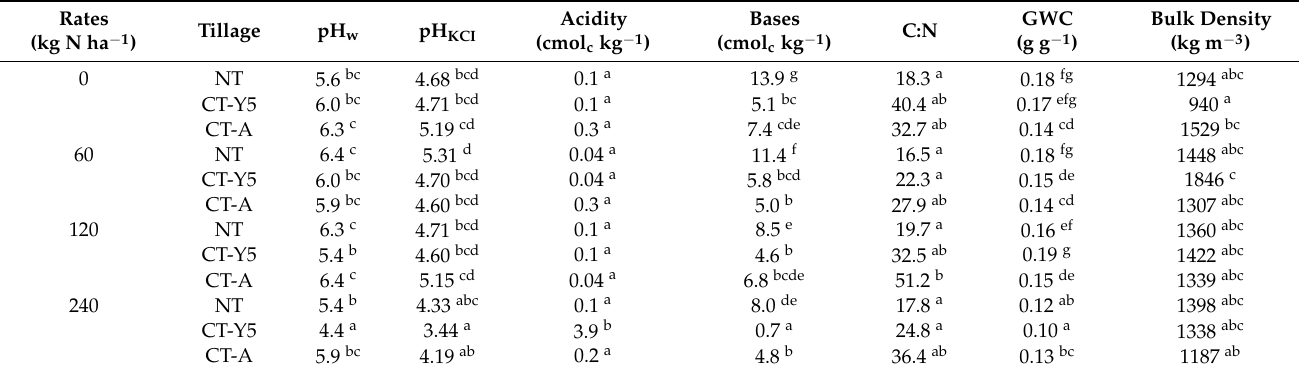
Table 1. Soil characteristics under different tillage systems and N fertilizer application rates at 0–10 cm depth.